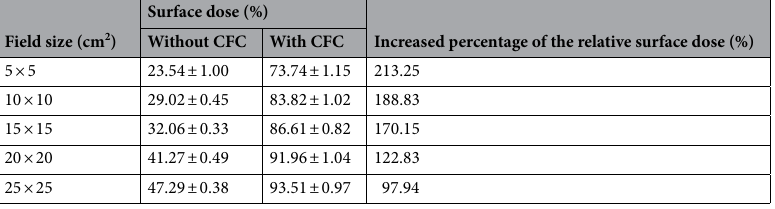
Field size (cm 2 )